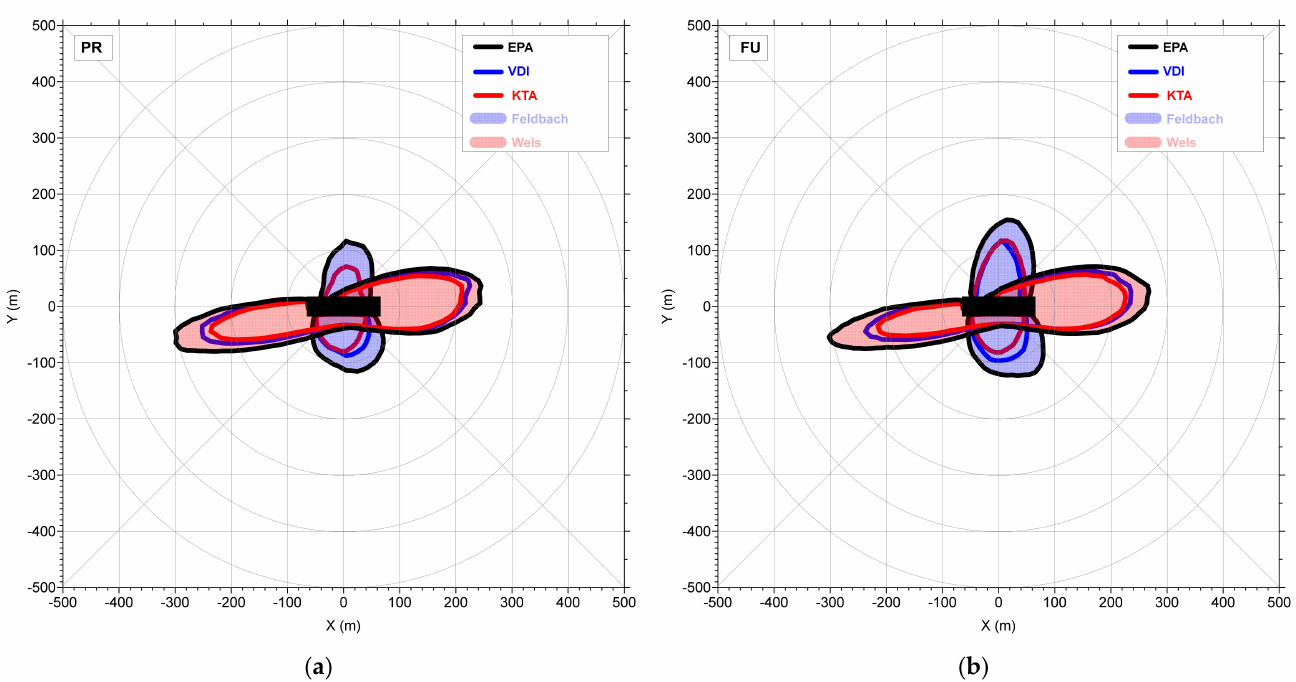
Figure 8. Direction-dependent separation distances (m) for 10% exceedance probability (pure residential areas) at Feldbach and Wels, ( a ) for PR (present climate (1981–2010)) and ( b ) FU (future climate (2036–2065)); based on a combination of global radiation and the vertical temperature gradient (EPA), cloudiness (VDI) and radiation balance (KTA), each in combination with wind speed, to determine stability classes; the black rectangle is the livestock building.